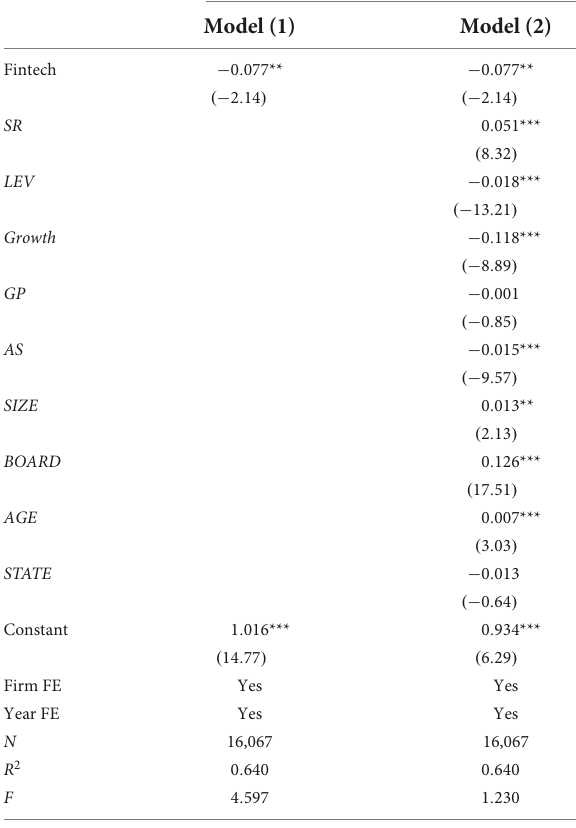
TABLE 4 Benchmark regression